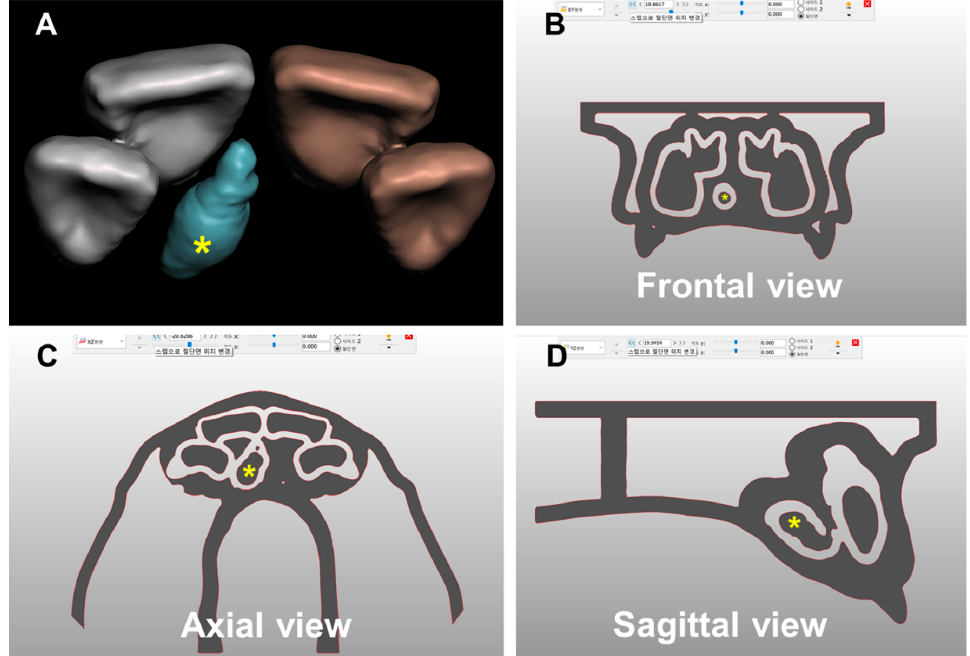
Figure 2. 3D localization of a supernumerary tooth in the 3D digitalized tooth model. ( A ) A supernumerary tooth was 3-dimensionally localized to imitate the natural positional relationship with adjacent permanent tooth germs, ( B ) frontal view of the 3D tooth model for the supernumerary tooth, ( C ) axial view of the 3D tooth model for the supernumerary tooth, and ( D ) sagittal view of the 3D tooth model for the supernumerary tooth. The asterisks refer to the supernumerary tooth.